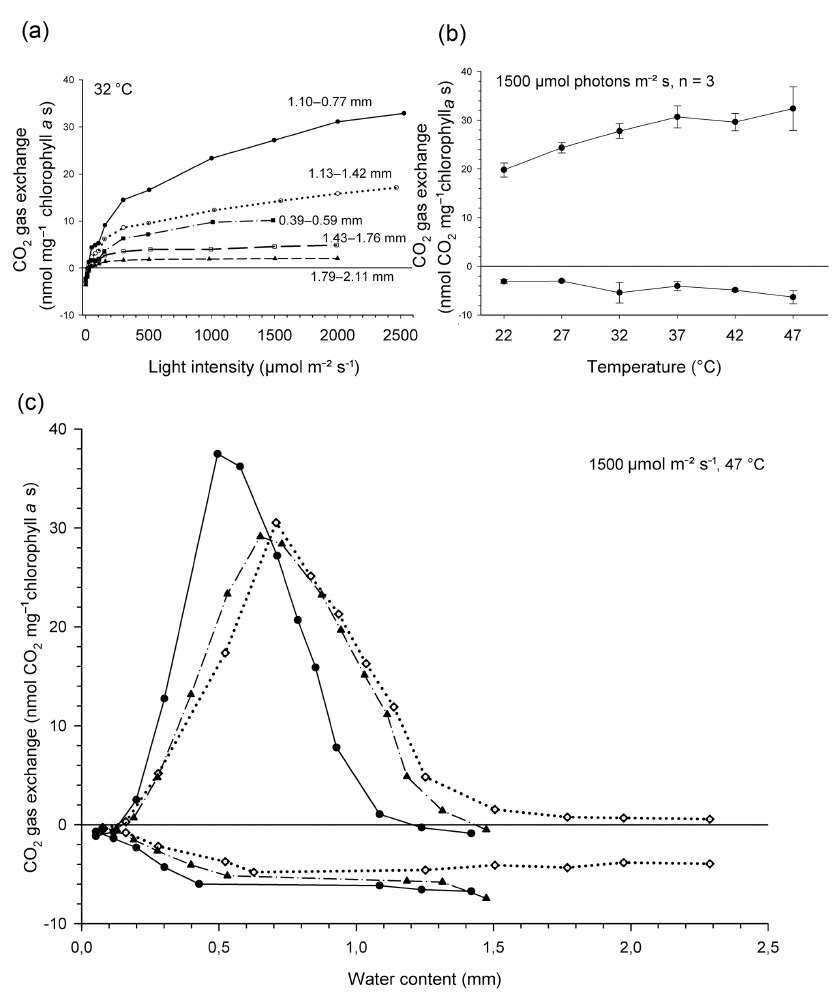
Figure 3. Response of net photosynthesis and dark respiration to water content, different PAR and temperature of the S. purpurascens - dominated biocrust. (a) Response of net photosynthesis to increasing PAR at different water content at 32 ◦ C, one out of three replicates shown; (b) response of net photosynthesis and dark respiration to increasing air temperature at 1500µmolphotonsm − 2 s − 1 and optimal WC, mean values of n = 3; (c) response of net photosynthesis and dark respiration of three replicates to increasing biocrust water content at 1500µmolphotonsm 2 s − 1 and an air temperature of 47 ◦